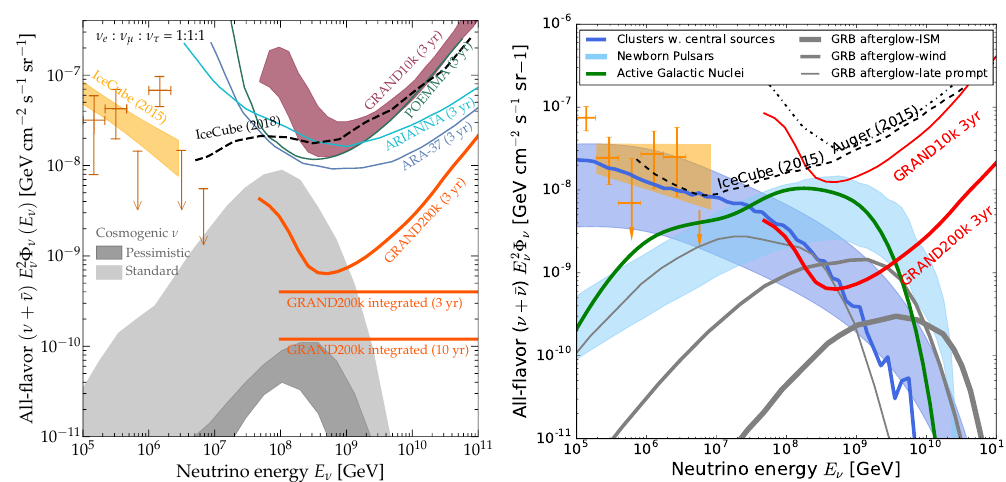
Figure 3. Left: cosmogenic neutrinos flux expectations derived from the latest results of the Pierre Auger Observatory [19] superim- posed to the di ff erential sensitivity limit derived from the 10000 antennas simulation presented in section 2.2 ("GRAND10k", purple area) and the extrapolation for the 20-times larger GRAND array ("GRAND200k", orange line). Right: expected neutrino fluxes pro- duced at the source for di ff erent types of sources superimposed to the GRAND10k and GRAND200k 3-years sensitivity limits. Taken from